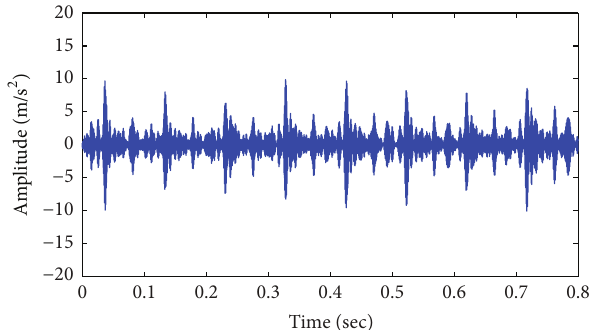
Figure 9: Reconstructed signal over the band of 850–1300 Hz.